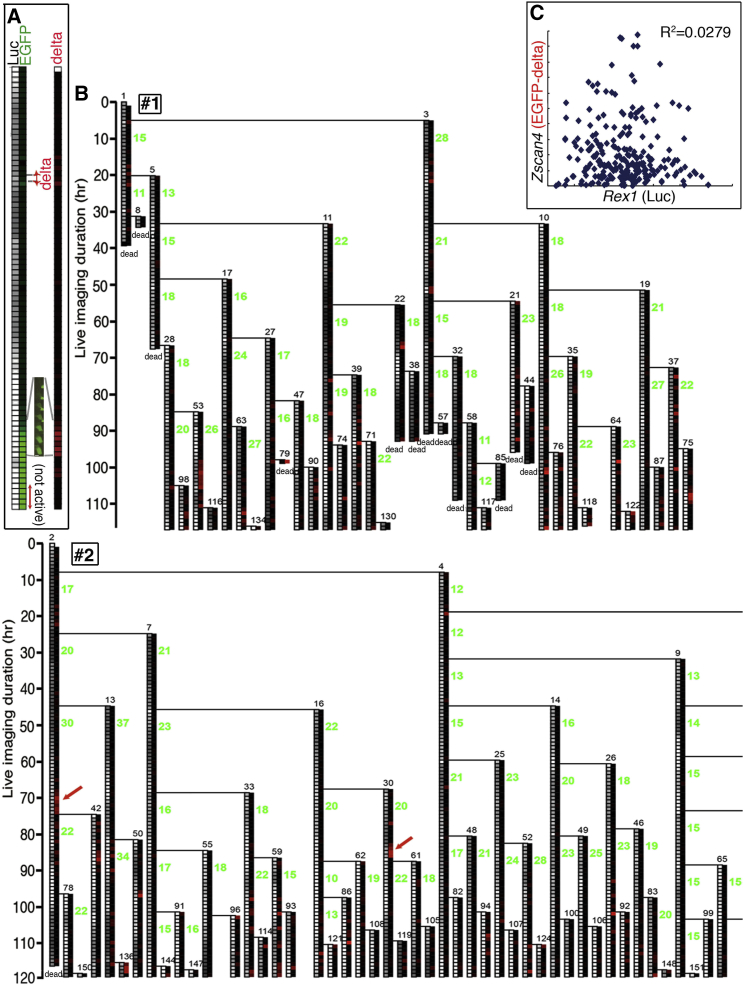
Monitoring Zscan4 Promoter Activity(A) The intensity of the chemiluminescence (represents Rex1 activity) and the logarithm of GFP intensity were converted to a gray scale and green scale, respectively, using a handmade program written in Microsoft VBA (Data S1). Due to the long half-life of EGFP (Figure S2B), GFP positive does not necessarily mean Zscan4 active. To evaluate Zscan4 promoter activities, the GFP intensities were converted to the increment of the intensity (delta indicated in the green scale; i.e., GFP(t + 1) − GFP(t)) as shown in the red scale. The actual image of the cell that showed upregulation of Zscan4 is shown together with the green and red scales. Bar, 7.5 μm. See also Figure S4B.(B) The lineage trees in Figure 2B were converted to delta signal. Subtle Zscan4 activity emerged (red arrows). See also Figure S5.(C) Rex1 and Zscan4 promoter activities obtained from the intensities of Luciferase and GFP, respectively, were calculated as the average per hour within each cell cycle (n = 391 cell divisions in eight lineages from two independent experiments). There was no correlation (R2 = 0.0279).